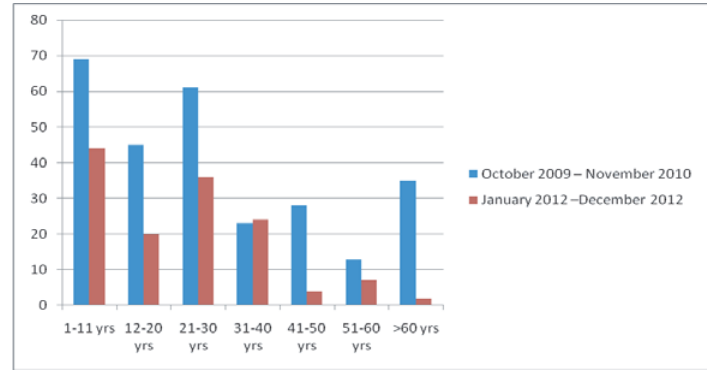
1. Age distribution of culture positive enteric fever subjects